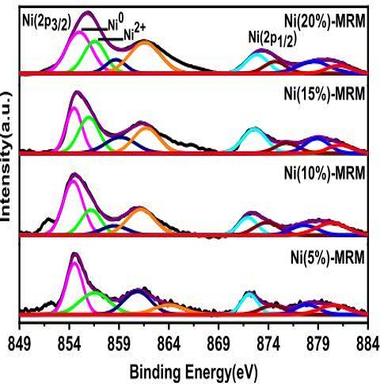
X-ray photoelectron profiles of Ni(2p) in Ni loaded MRM sample materials.